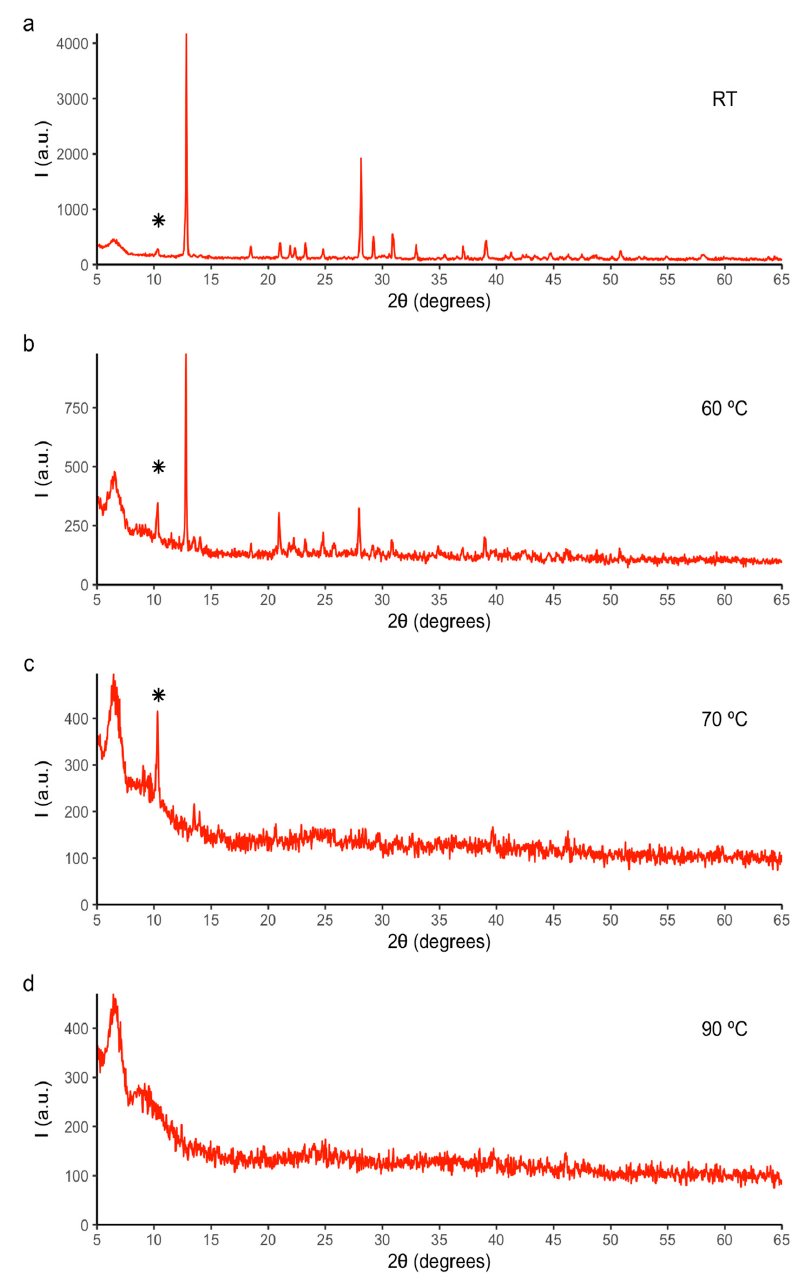
Figure 4. X-ray powder diffraction of cobalt (II) acetate commercial sample heated under N 2 atmosphere at: ( a ) room temperature, ( b ) 60 °C, ( c ) 70 °C, and ( d ) 90 °C. Main phase in the starting room temperature scan is the cobalt acetate tetrahydrate (PDF-00-025-0372), but the dihydrate phase (PDF-00-022-1080) can also be observed as a minor phase (main peak marked with an asterisk in a, b, and c scans). ( a – c )